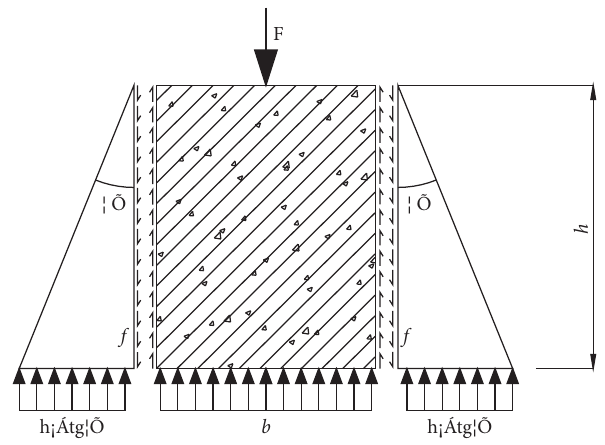
Figure 14: Sketch map of calculative width. Table 4: The coefficient of b